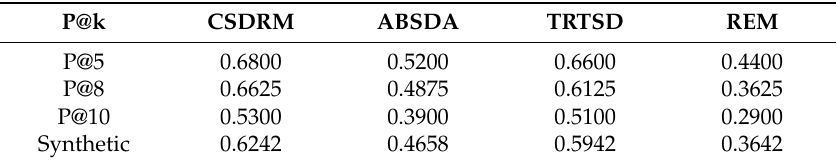
Table 2. Precision comparison of Top-k